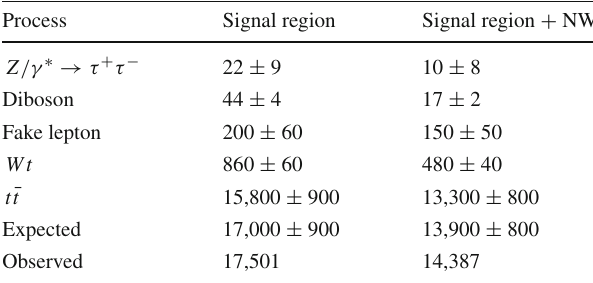
Table 1 Event yields in the signal selection, and after requiring that neutrino weighting (NW) reconstructs the event. The quoted uncer- tainties include uncertainties from leptons, jets, missing transverse momentum, luminosity, statistics, background modelling and pile-up modelling. They do not include uncertainties from PDF or signal t ¯ t modelling. The results and uncertainties are rounded according to rec- ommendations from the Particle Data Group (PDG)